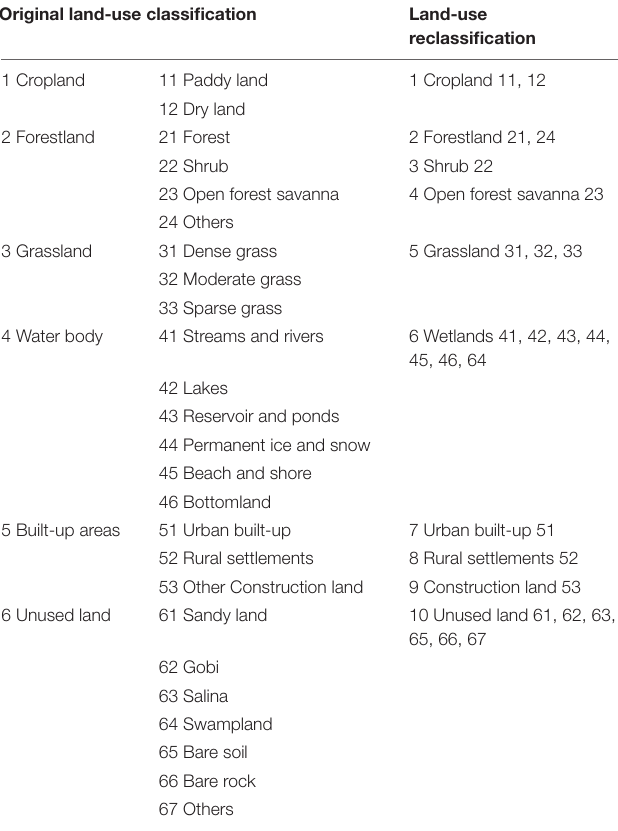
TABLE 1 | Land-use